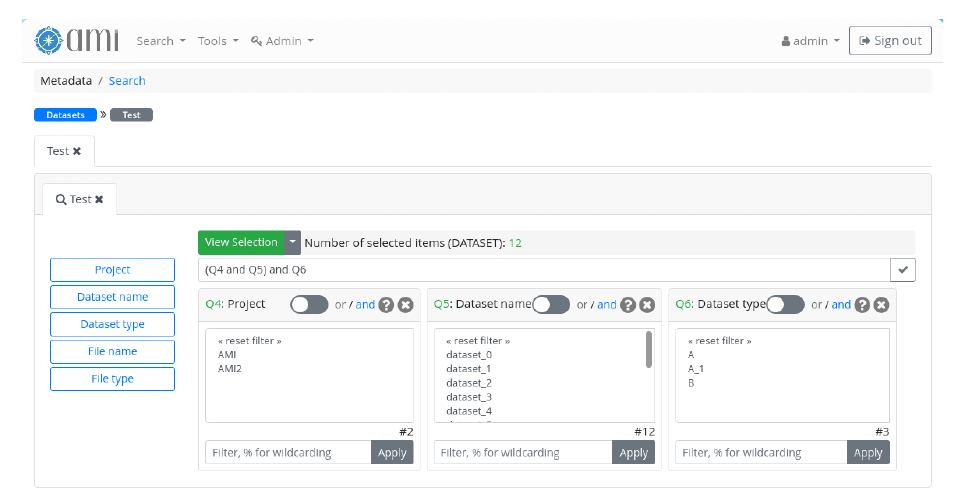
Fig 5. Screenshot of the resulting search interface (see associated database schema Figure 3) for searching “Datasets” by “Project”, “Dataset name”, “Dataset type”, “File name” and “File type”. If is selected “Project”=’AMI’ and “Dataset name”=’dataset_2’, the resulting MQL query will be: SELECT * WHERE [`test`.`PROJECT`.`name` = 'AMI'] and (`test`.`DATASET`.`name` =